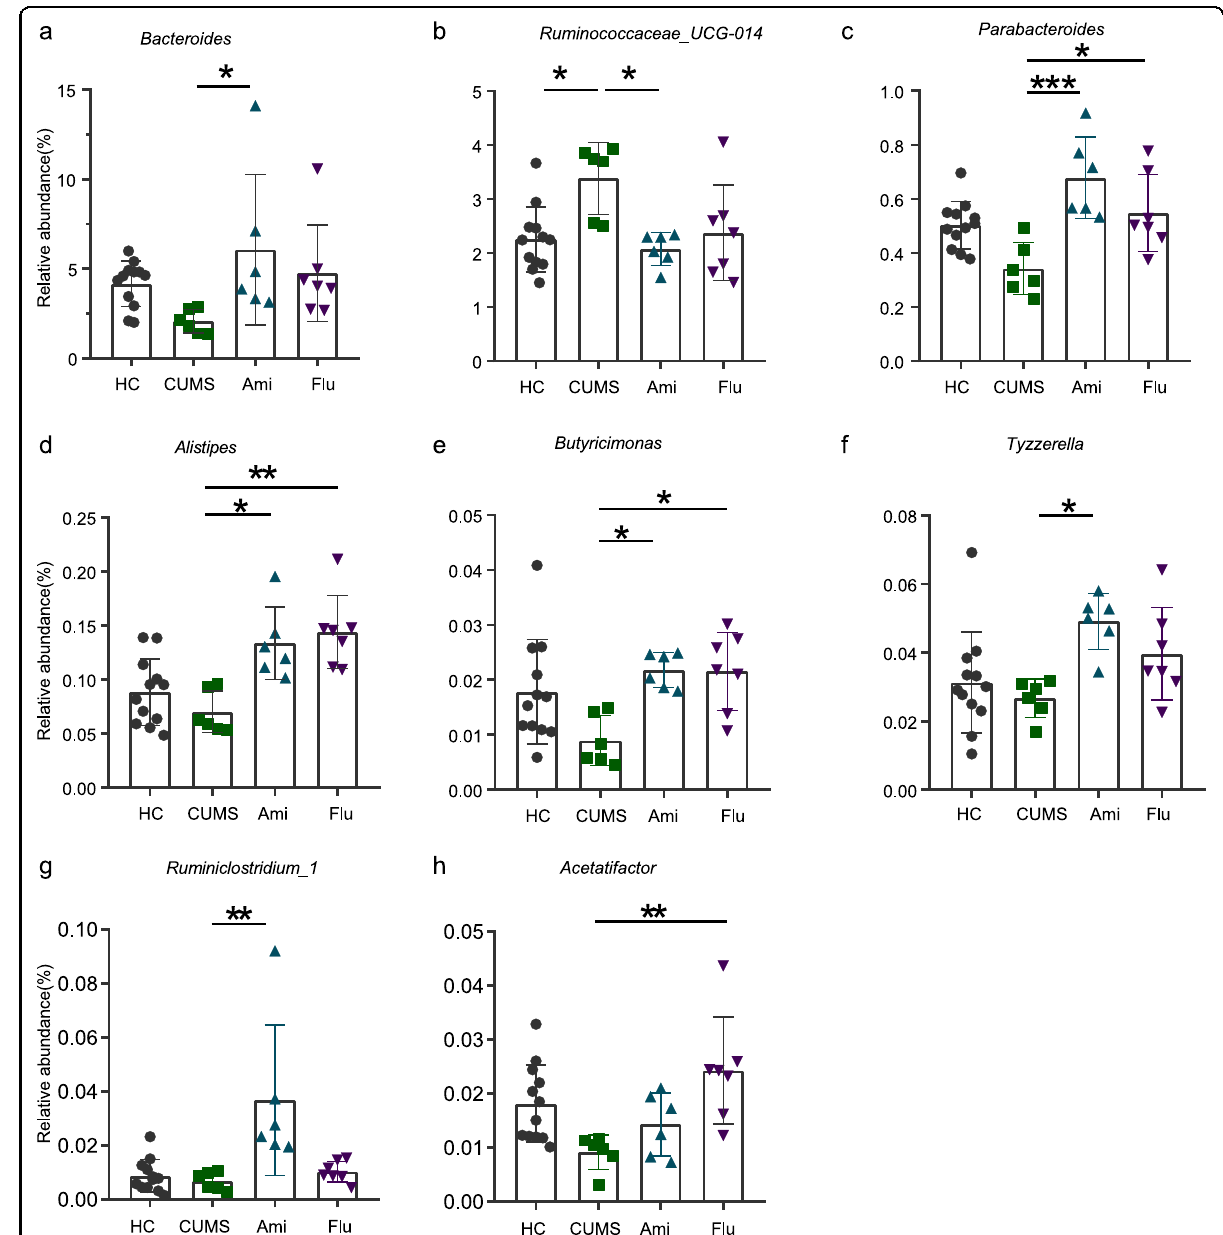
Fig. 4 Faecal microbiota changes following antidepressants treatment at the genus level. Kruskal – Wallis H followed by Tukey ’ s posthoc tests statistics of the relative a – i bacterial genera abundance in HC, CUMS, Ami, and Flu groups. Signi fi cant different are indicated: * P < 0.05, ** P < 0.01, *** P <